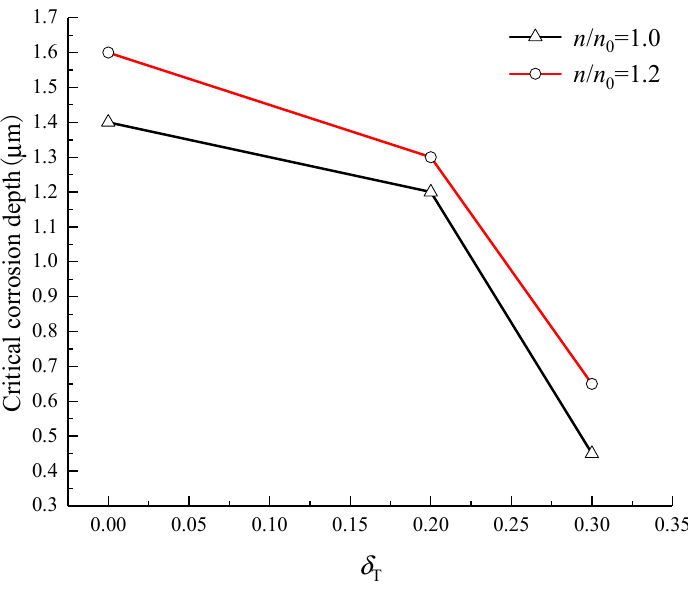
Figure 9. Critical corrosion depth of steel bars when the IBSC cracks.